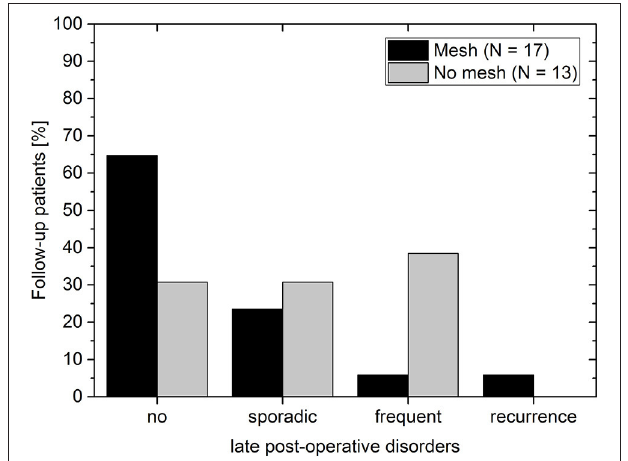
FIGURE 5 | Post-operative disorders at the late follow-up for patients with mesh (black bars) and without mesh (gray bars). Post-operative disorders include instances of pain, regurgitation, or